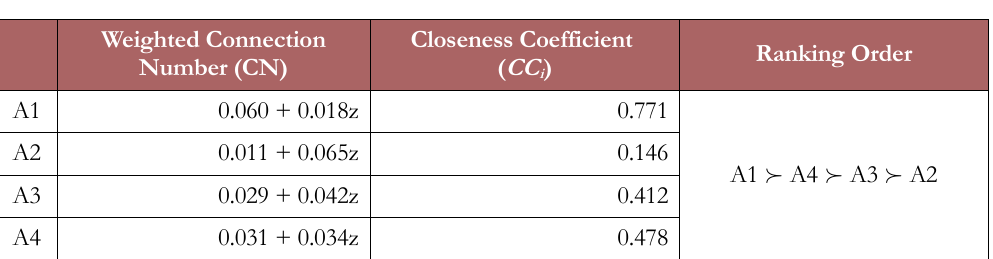
Table 23. Weighted connection number, closeness coefficient, and ranking